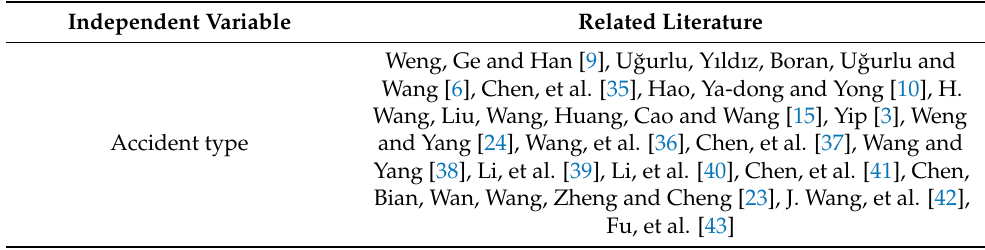
Table 1. Literature of independent